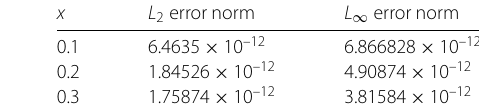
Table 6 The error norm in the solution of TFCRDEs by HATM for λ = 1 x L 2 error